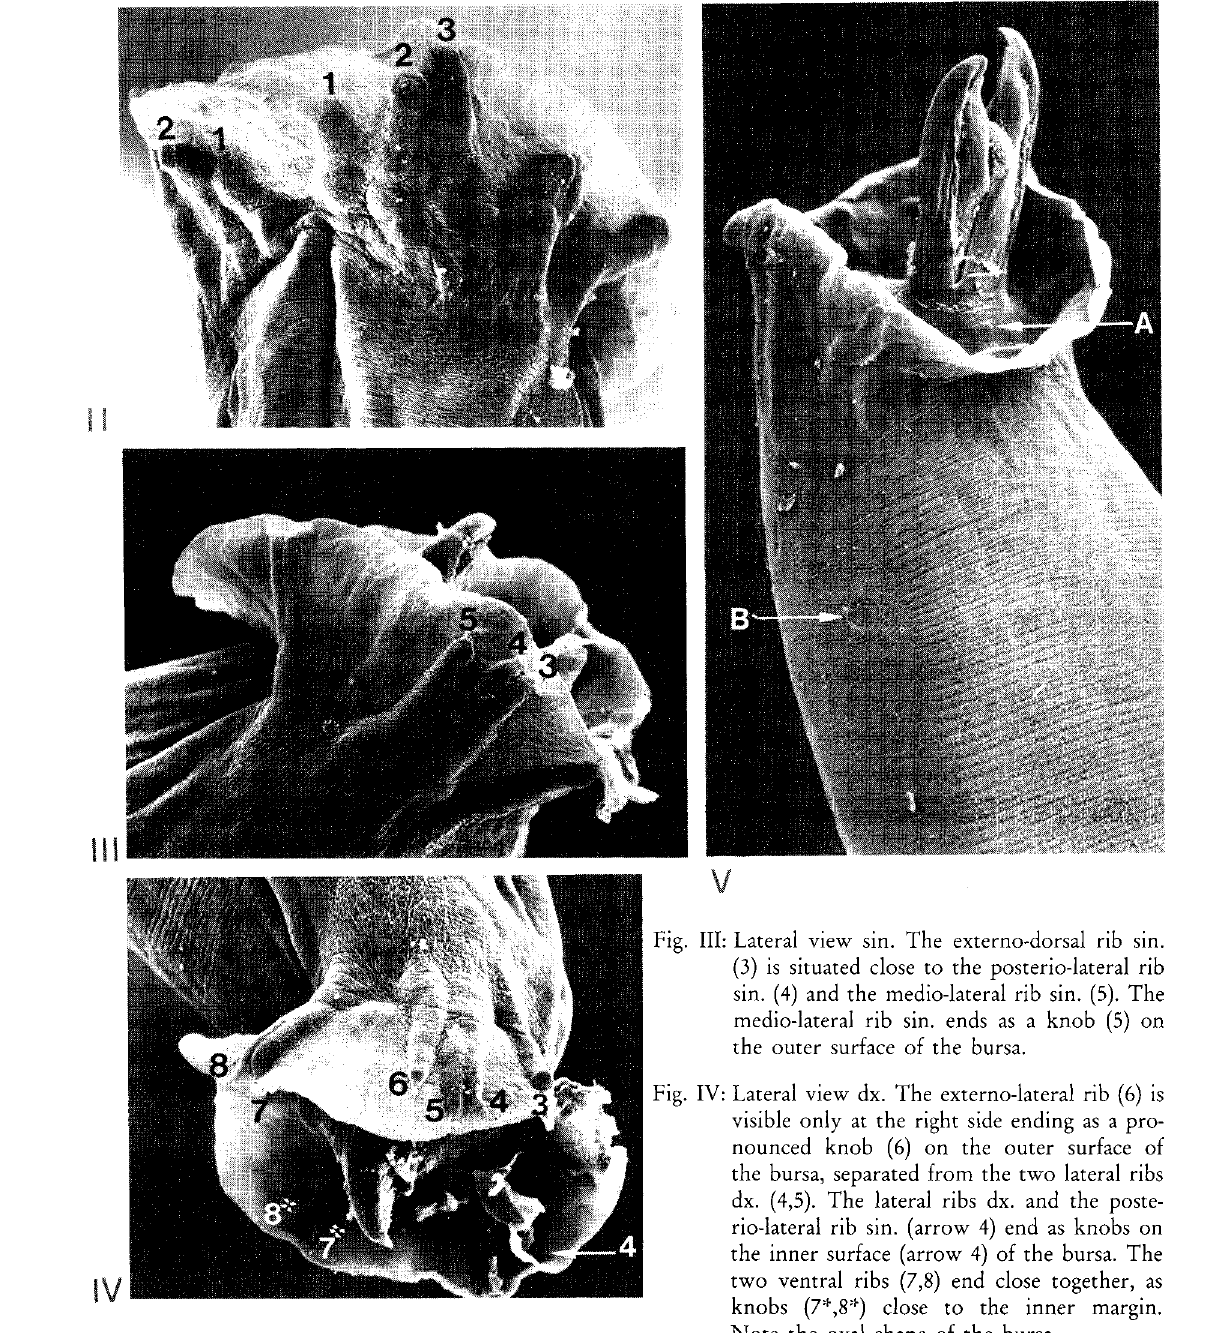
Fig. II-V: Elaphostrongylus sp. from moose. Male ge nital bursa. Fig. II: Dorsal view. Dorsal rib, split to the base, di vided into two dorso-dorsal (1,1), two medio¬ dorsal (2,2), and one externo-dorsal (3) rib dx. The medio-dorsal ribs end as knobs (2,2) on the outer surface of the bursa.